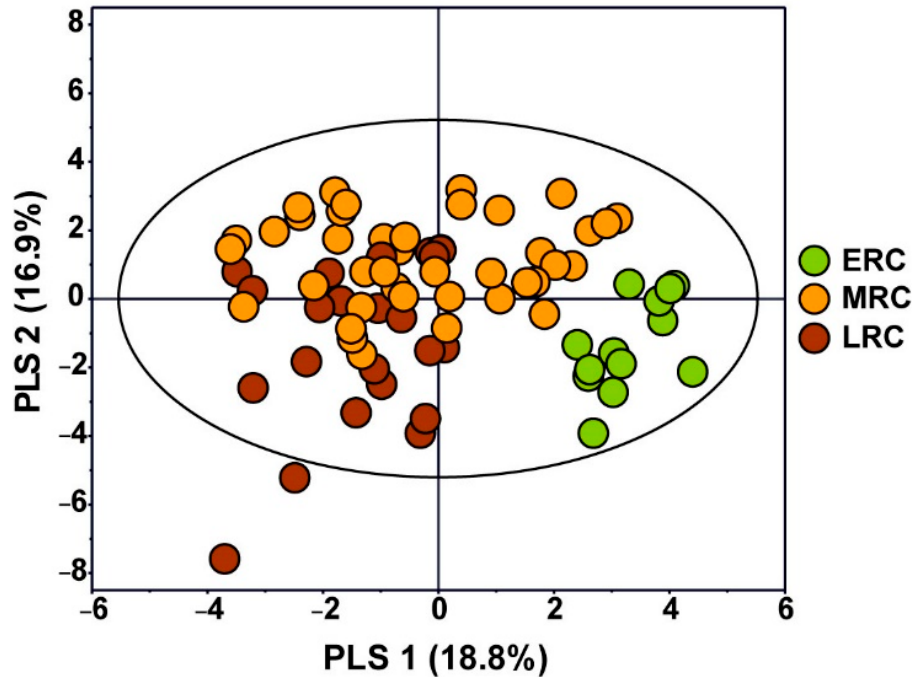
Figure 4. PLS-DA score plot (R 2 X = 0.357, R 2 Y = 0.417, Q 2 = 0.324) of quantified metabolites in ERC, MRC, and LRC of C. crenata chestnut. Letters on the legend represent: ERC, early-ripening cultivar; MRC, mid-ripening cultivar; LRC, late-ripening cultivar.